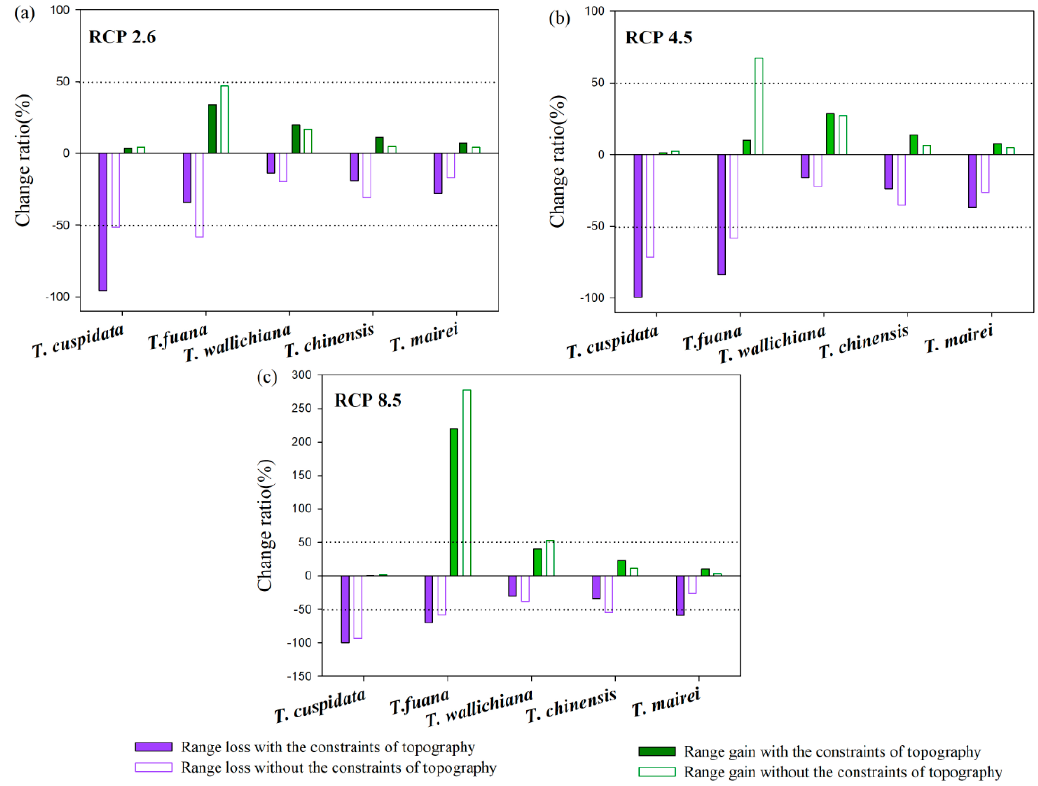
Figure 6. The range loss and gain components for each species between SDMT and SDMWT.